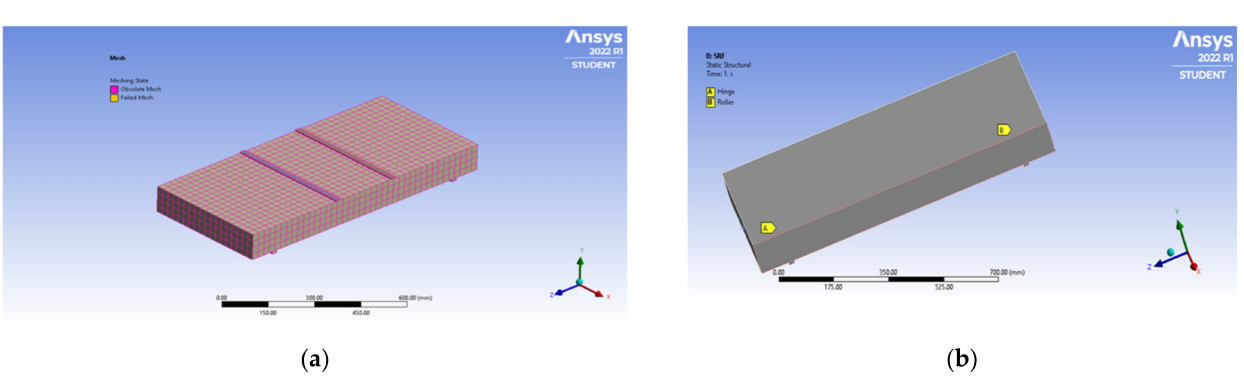
Figure 16. Slab model in ANSYS 2022-R1: ( a ) meshed model; ( b ) support conditions.